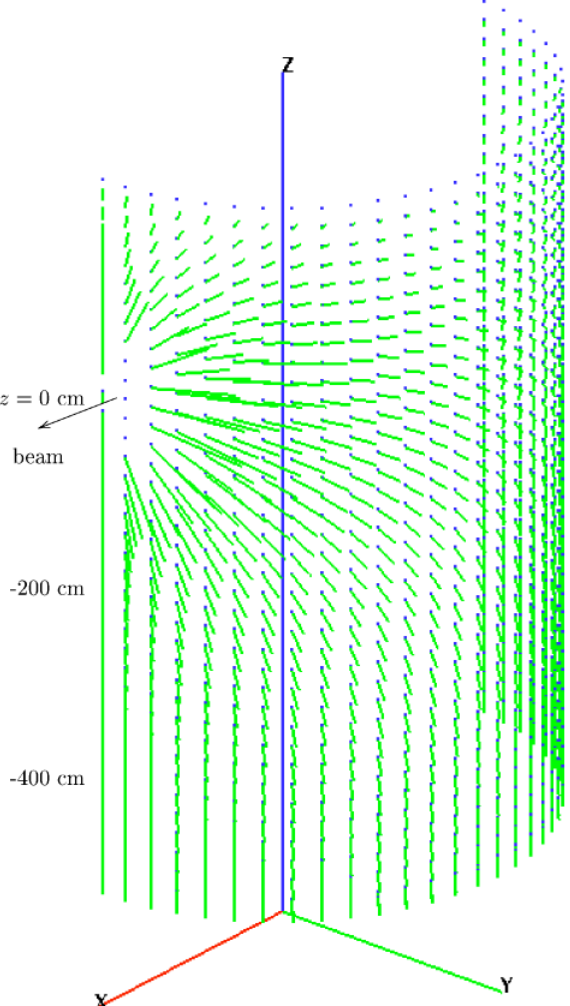
FIG. 3. (Color) Vector plot of surface currents flowing in the wall of the injector vessel.